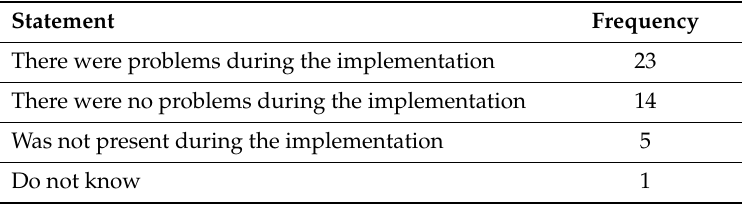
Table 17. Evaluation of the implementation process (N =